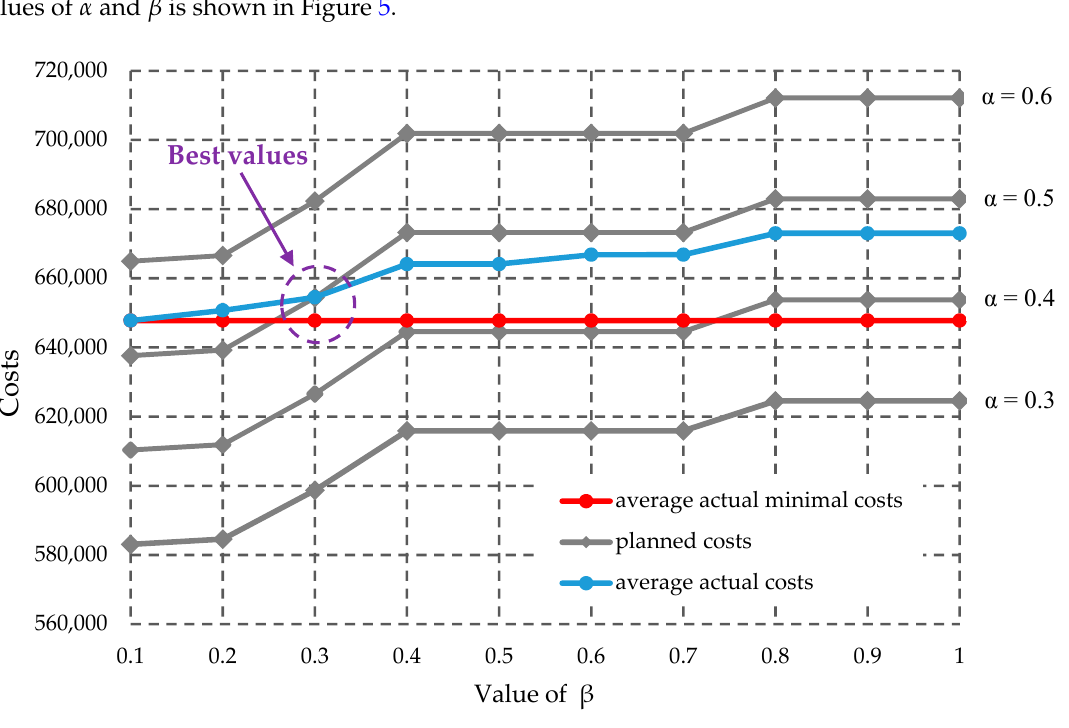
Figure 5. Sensitivity of the three kinds of costs with respect to the values of α and β .